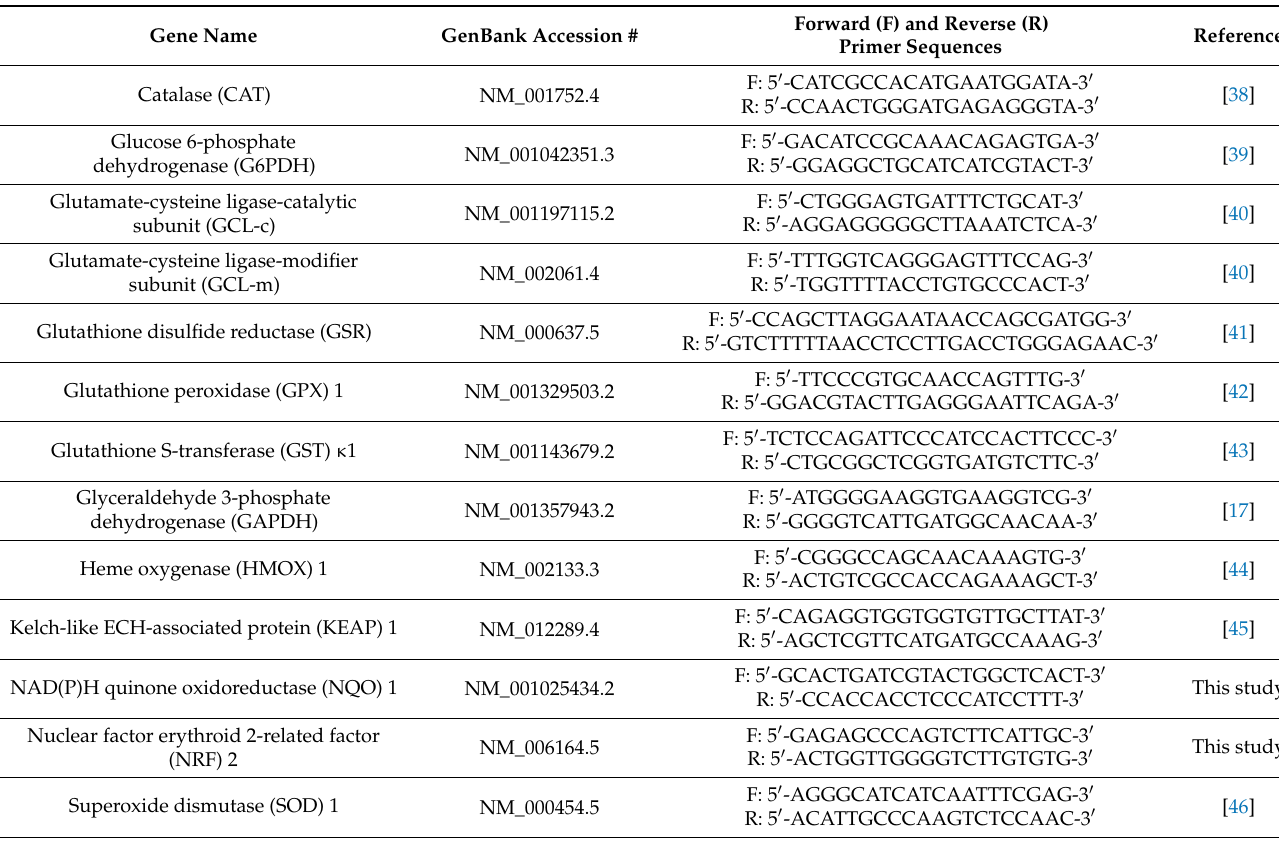
Table 1. Sequences of primers used for the quantitative reverse transcriptase-polymerase chain reaction (qRT-PCR) of gene